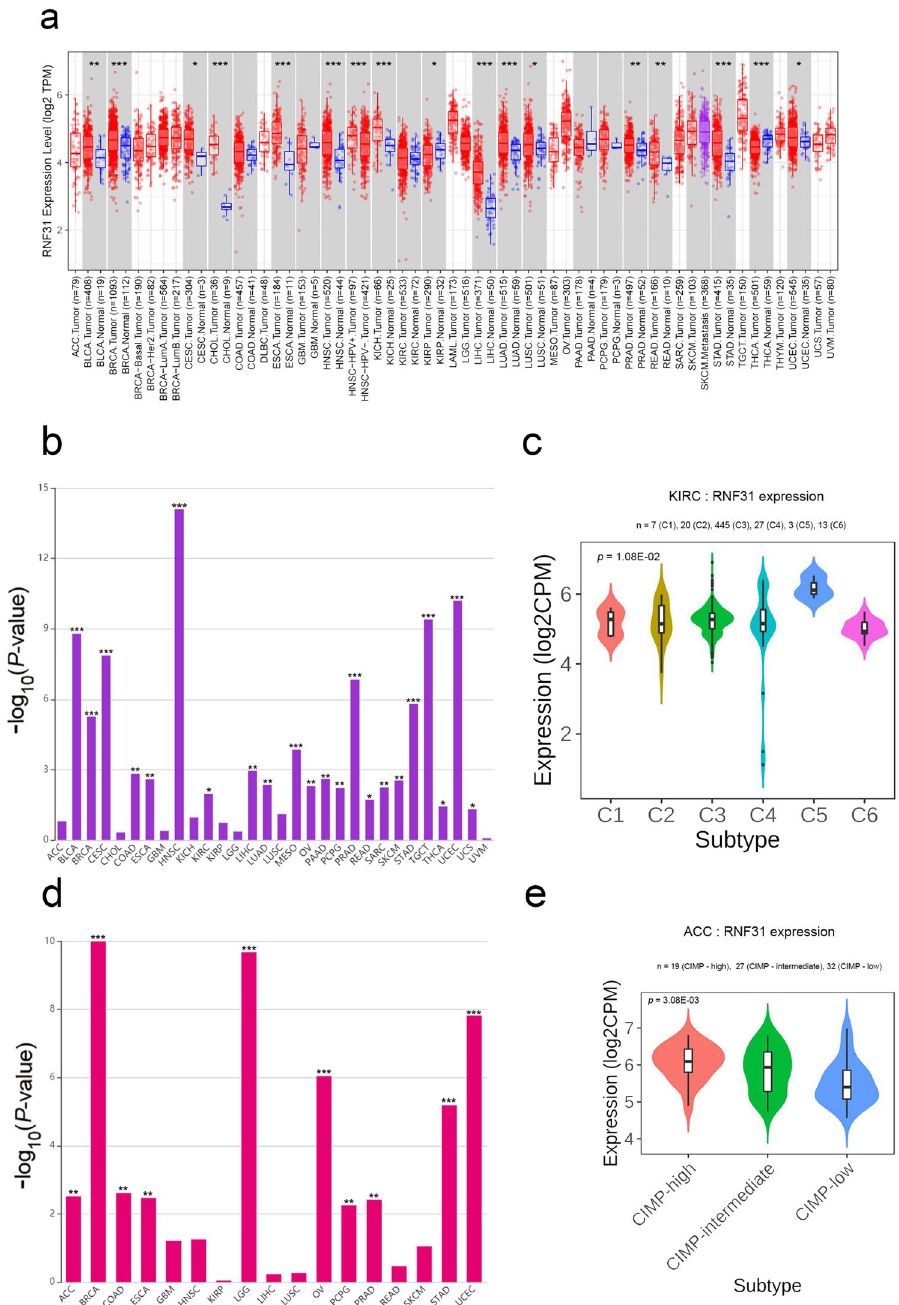
Figure 1. RNF31 expression levels in human cancers. ( a ) Detection of the expression level of RNF31 in different cancers in TCGA database by TIMER (TPM = transcripts per million, * P < 0.05, ** P < 0.01, *** P < 0.001). ( b ) Kruskal–Wallis Test results of RNF31 expression in different immune subtypes across human cancers (* P < 0.05, ** P < 0.01, *** P < 0.001). ( c ) Expression levels of RNF31 in different immune subtypes of KIRC (n = number of patients with available data, log2CPM: log2 on counts per millions). ( d ) Kruskal–Wallis Test results of RNF31 expression in different molecular subtypes across human cancers (* P < 0.05, ** P < 0.01, *** P < 0.001). ( e ) Expression levels of RNF31 in different molecular subtypes of ACC. CIMP: